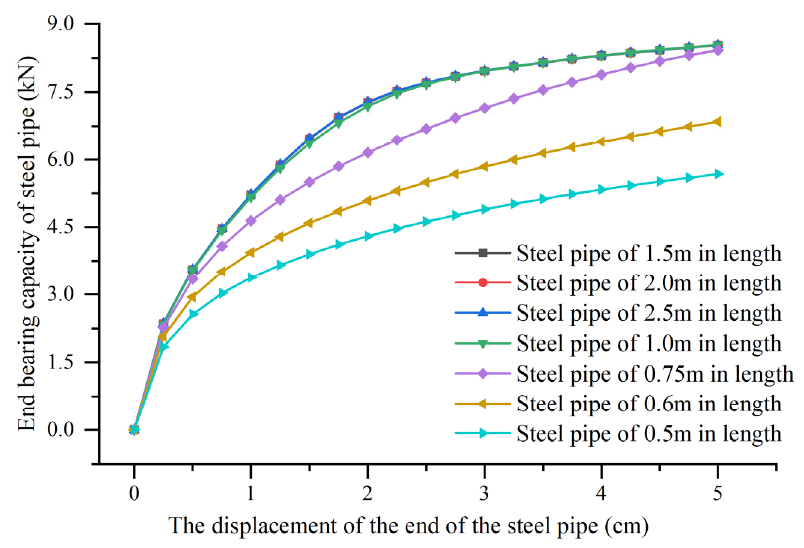
Figure 13. Relationship between pipe length and bearing deformation curve of steel pipe.